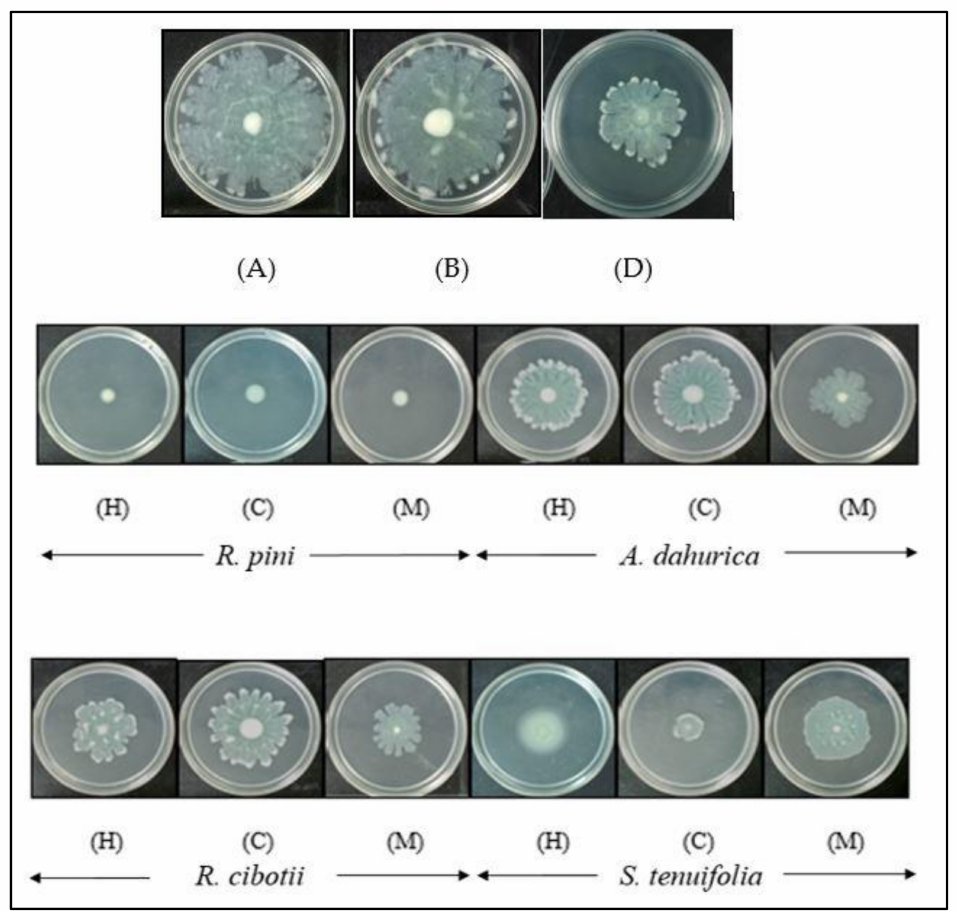
Figure 5. The effects of the four plant extracts ( R. pini , A. dahurica , R. cibotii and S. tenuifolia ) on the swarming motility in P. aeruginosa PAO1 at the concentration of 1 mg/mL in hexane [H], chloroform [C] and methanol [M] extraction. Swarming agar inoculated with (A) P. aeruginosa PAO1 alone, (B) P. aeruginosa PAO1 supplemented with DMSO (10% v / v ), and (D) P. aeruginosa PAO1 supplemented with Malabaricone C at 1 mg/mL. All the samples reduce swarming in PAO1 with R. pini showing the strongest